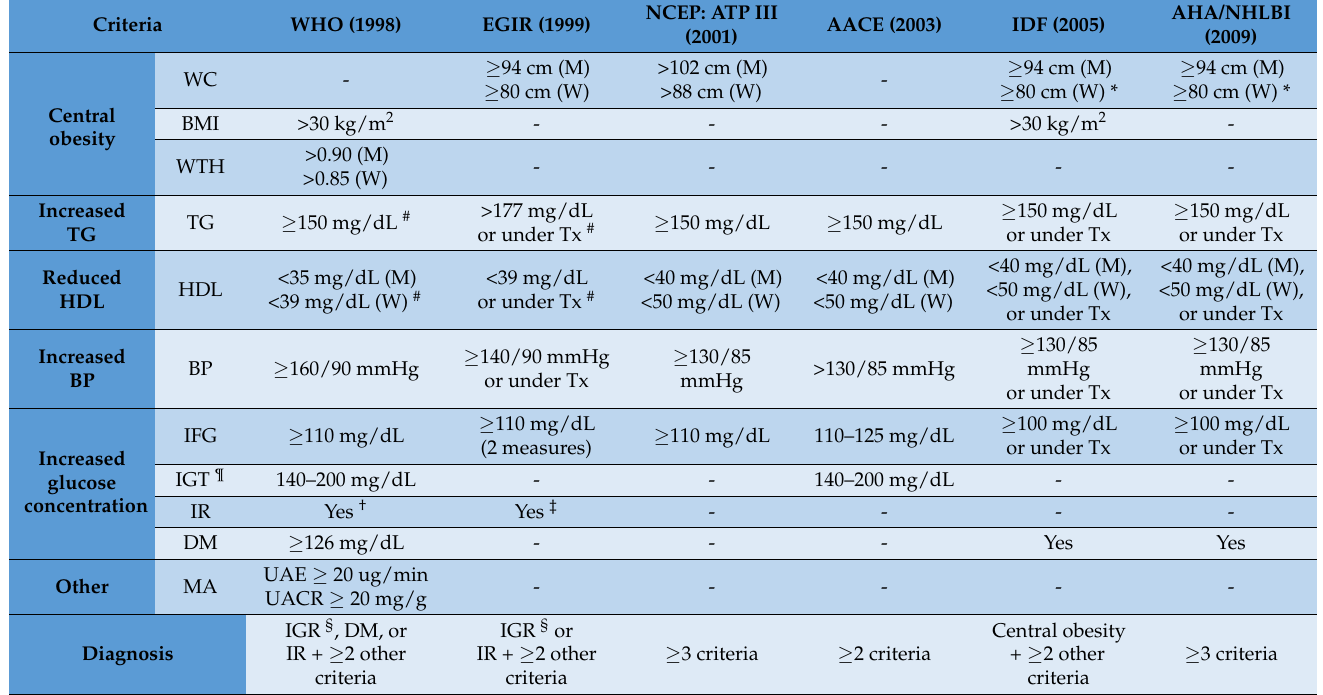
Table 1. Clinical operant definitions of metabolic